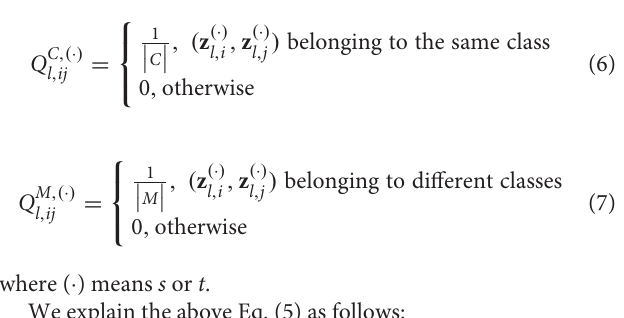
classification error terms for the last layer of the source